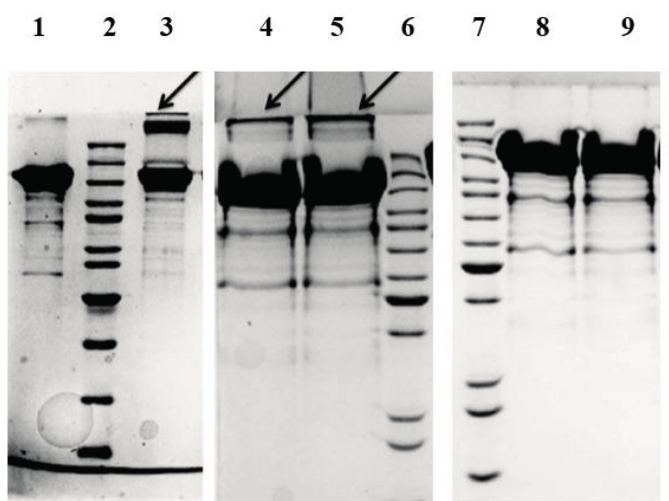
Figure 2. SDS-PAGE of SlfB with different modifications: lane 1—native SlfB; lane 3—native SlfB crosslinked with EDC; lane 4—SlfB modified with an 4-fold excess of SATA and modified with EDC and; lane 5—same protein as in lane 4 and deacetylated; lane 8—SlfB modified with an 20-fold excess of SATA and modified with EDC; lane 9—same protein as in lane 8 and deacetylated; lane 2, 6, and 7—molecular weight standard with 200, 150, 120, 100, 85, 70, 50, 40, 30, 25, and 20